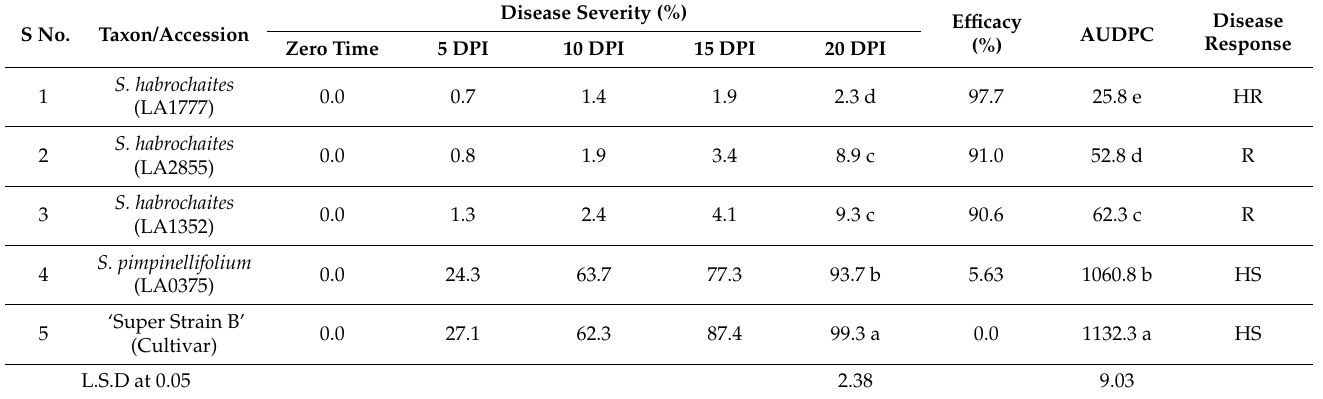
Table 1. Late blight disease severity percentage for four wild tomato accessions and commercial variety ‘Super Strain B’ inoculated with P. infestans isolate EG_7 under greenhouse conditions. Results from 2020 1